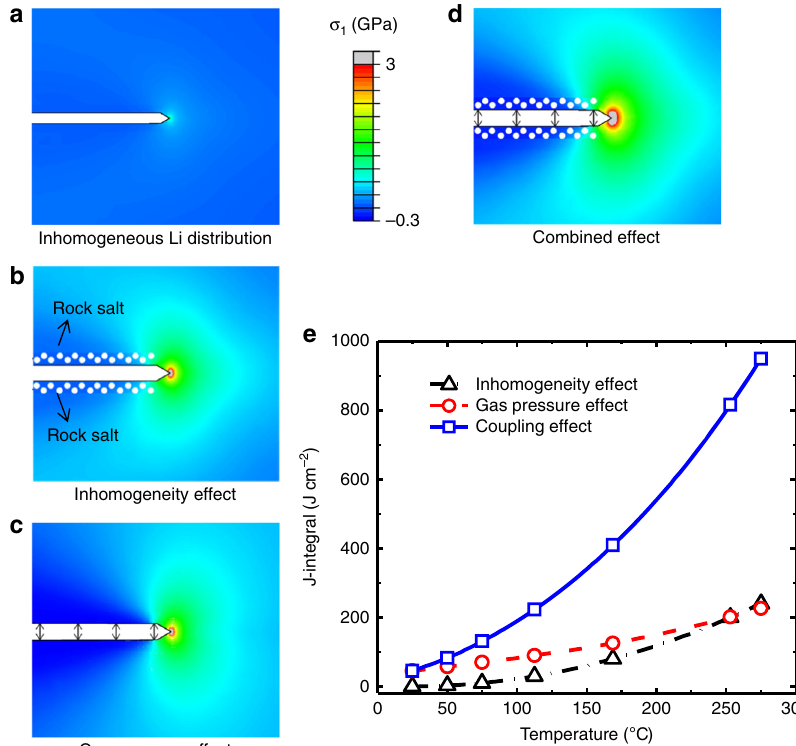
Fig. 6 Modeling of the driving force for crack propagation in heated LiNi 0.6 Mn 0.2 Co 0.2 O 2 . The driving force is indicated by stress at the crack tip and measured by J -integral, upon considering material heterogeneity and crack surface pressure by the released oxygen gas. a Driving force for crack propagation without heat treatment considering inhomogeneous lithium distribution ( J = 45 J cm ‒ 2 ). b Driving force for crack propagation with heat treatment (heated to 275 °C) considering the material inhomogeneity, in terms of both inhomogeneous lithium concentration and rock-salt phase formation ( J = 226 J cm ‒ 2 ). c Driving force for crack propagation considering the surface pressure exerted by thermal decomposition generated oxygen molecules trapped within the crack at elevated temperature of 275 °C ( J = 240 J cm − 2 ). d Fracture driving force when considering both the effects in ( b ) and ( c ) ( J = 950 J cm ‒ 2 ). e J -integrals of the crack as a function of